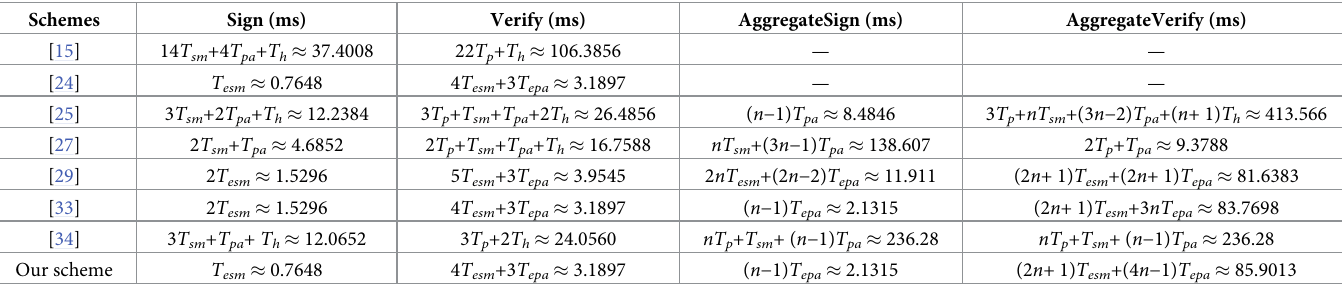
Table 3. Comparison of computational